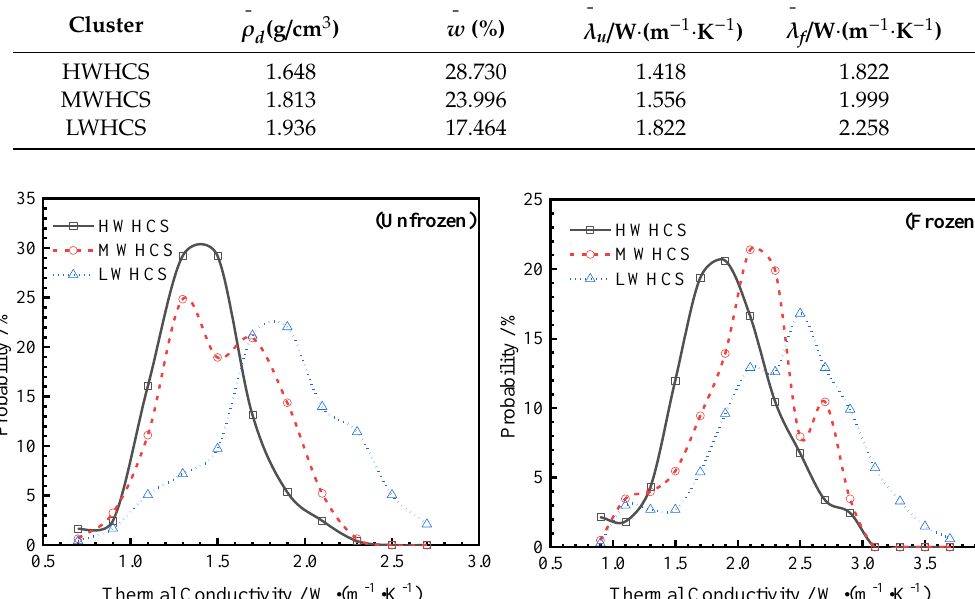
Table 3. Average thermal conductivity for three soil clusters.